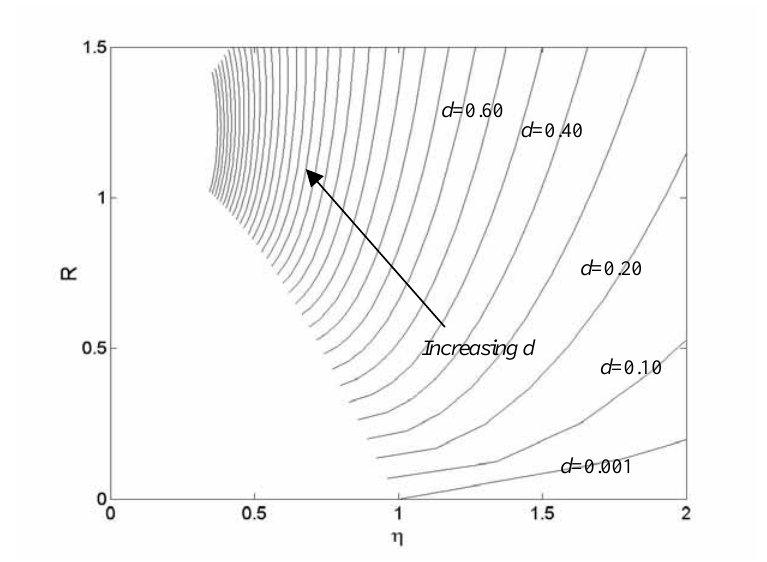
Fig. 17. Lines of constant damping with varying stiffness.